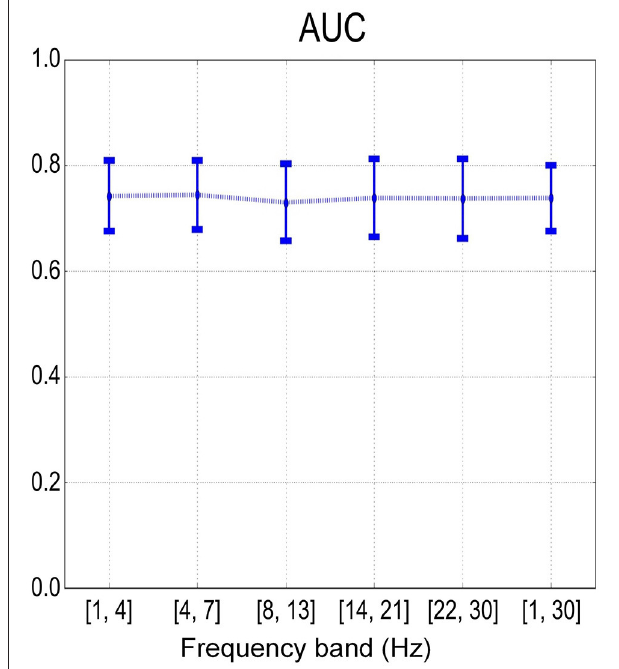
FIGURE 8 | Sample-based performance (AUC) across different frequency bands using the SMR-based processing method. The meaning of the boxplot was the same as that in Figure 4 .